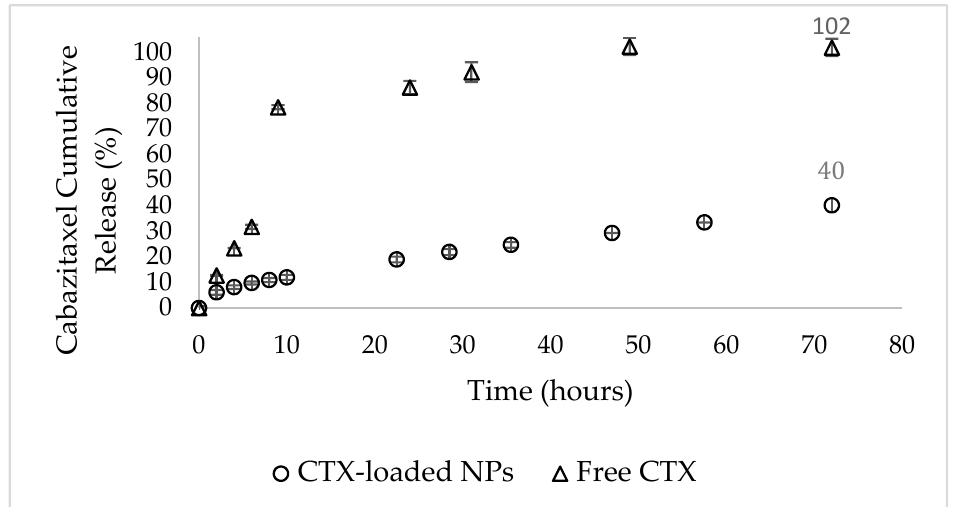
11 of 21 Figure 6. Analysis of the morphology of NPs by Cryo-TEM. Cryo-TEM images of ( A ) 0.6:1 CTX: SA- PEG NPs; and ( B ) NLCs not encapsulating a drug, in water. The scale bars denote 100 nm. Note that the CryoTEM images only show examples of the morphology of typical NPs. For size statistics, please refer to the DLS data. 3.5. In Vitro Profile of CTX Release from the NPs The time-course of in vitro release of CTX from NPs was assessed by dialysis in a large volume of a PBS buffer pH 7.4 containing 0.1% wt Tween 80 for 72 h at 37 ℃ , with continuous mixing. We used a buffer containing Tween 80 so that the hydrophobic drug released from the NPs was efficiently bound and solubilized by Tween 80%, mimicking human serum albumin binding of hydrophobic drugs. The above conditions were used to simulate the systemic circulation of NPs in the blood over 24–48 h, assuming this was a typical time for circulating NPs to accumulate in the tumor via the EPR effect [87]. At defined time intervals, the dialysate was replaced with fresh buffer, and the drug was quantified using RP-HPLC [72,73]. The complete replacement of fresh release buffer caused a stronger release driving force and constituted stringent release conditions [72,73]. The in vitro release profile of CTX from NPs showed substantial drug retention, as opposed to a burst - release of the unencapsulated drug during the first 10 h (Figure 7). These results were affected by the ratio between the liquid and solid lipids in the NPs formulation. As previously reported [41–43], the solid lipids of NLCs form a crystalline